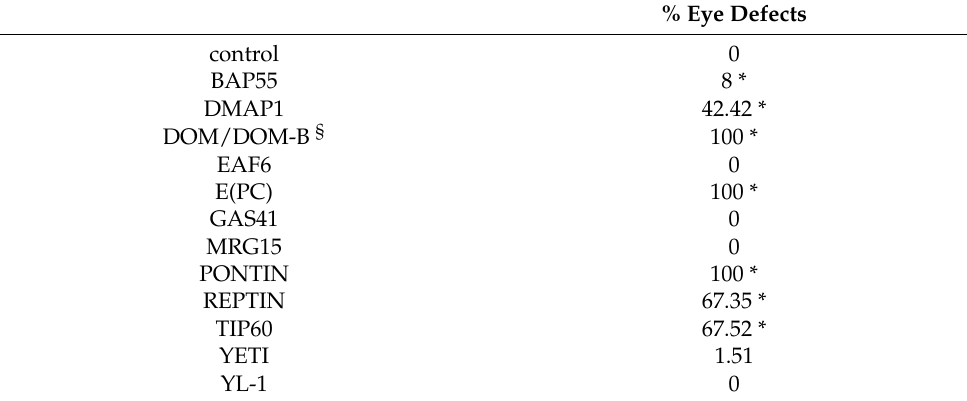
Table 4. Quantification of eye defects after silencing of genes coding for the subunits under investiga- tion. About 60 flies were scored for each subunit. The results are expressed as % mean. p < 0.05 (*), compared to the control. § Simultaneous